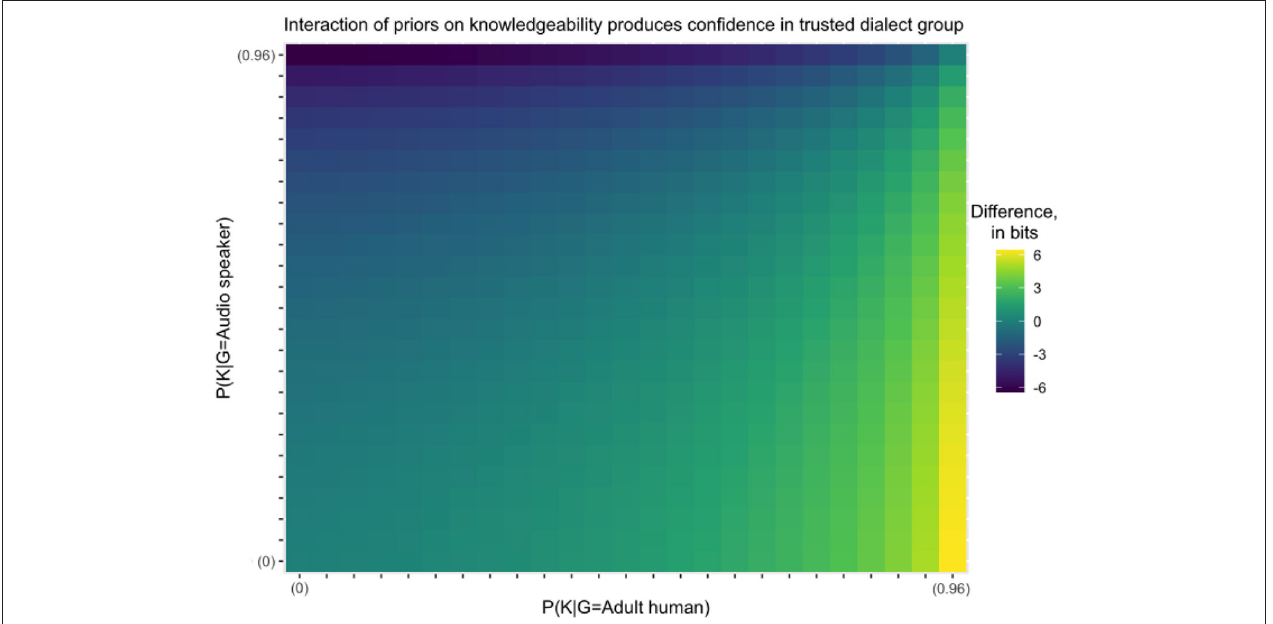
FIGURE 3 | The difference between the KL divergence for adult humans given incorrect and correct data, less the difference between the KL divergence for audio speakers given incorrect and correct data. The axes on the graph span most of the range between 0 and 1, but omit the last interval because KL divergence after hearing incorrect data is undefined when the prior on knowledgeability is